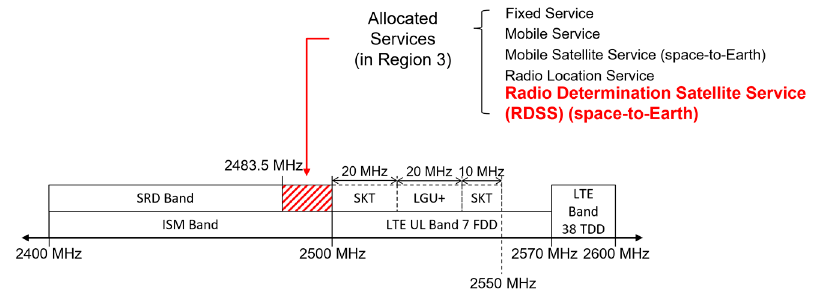
Figure 1. Frequency allocation of the 2.4–2.6 GHz band in South